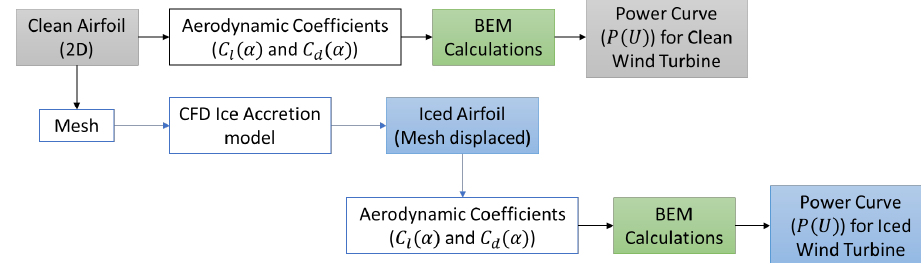
Figure 4. Diagram of CFD–BEM method.